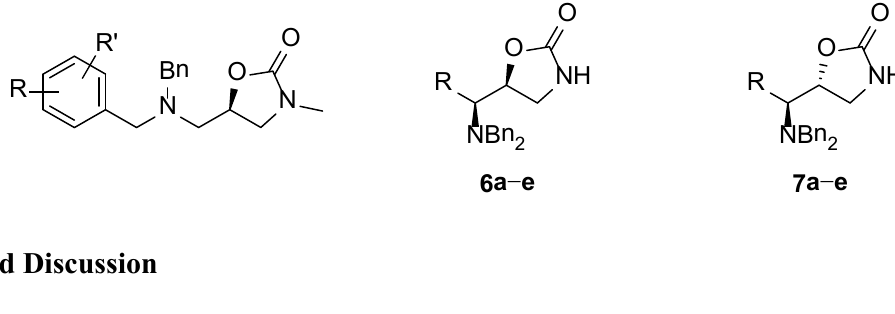
Figure 2. Chemical structure of chiral 5-substituted